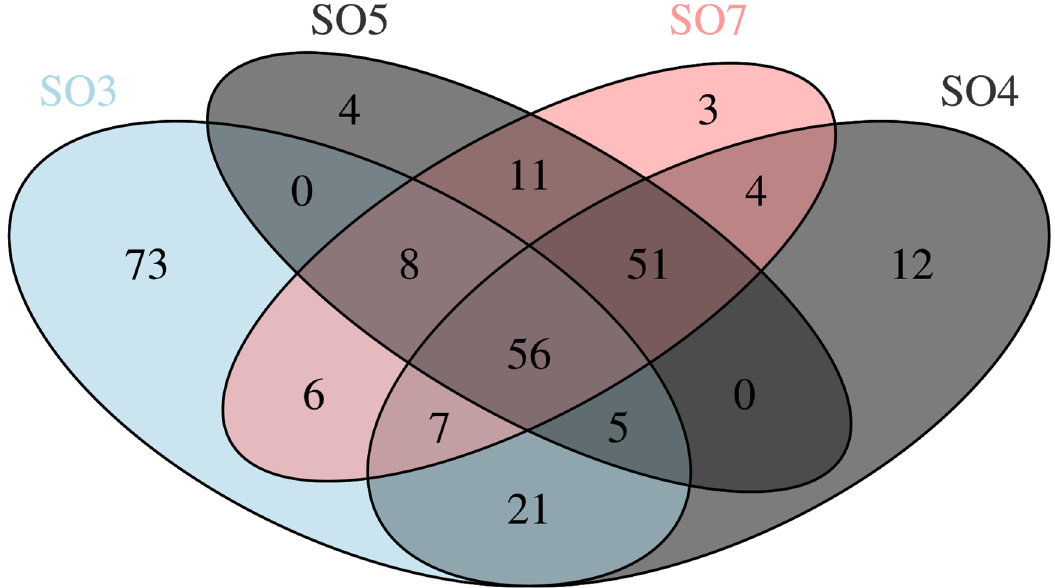
Fig 4. Venn diagram showing the number of core, unique and shared species among the different sampling points. Due to the presenceof humancontaminations, SO1 and SO2 have been omitted. SO6 has been omitted due to the almost sole presenceof